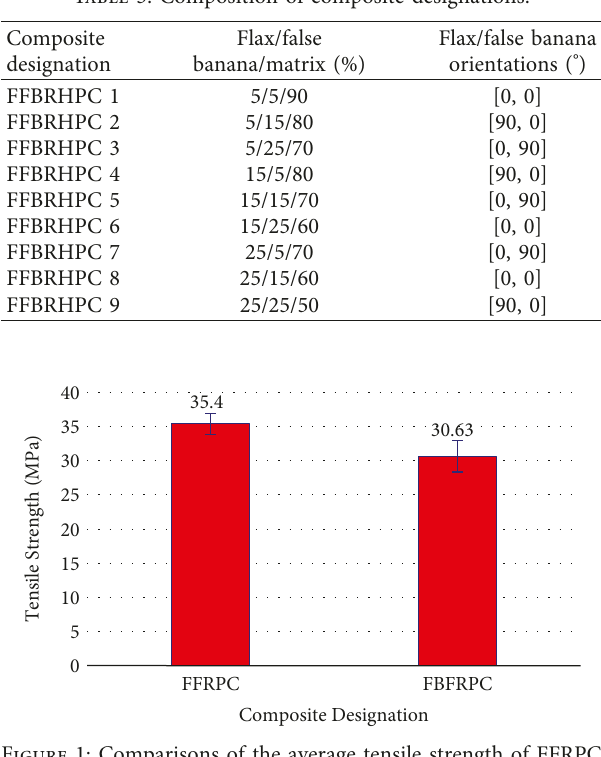
Figure 1: Comparisons of the average tensile strength of FFRPC and FBFRPC composite